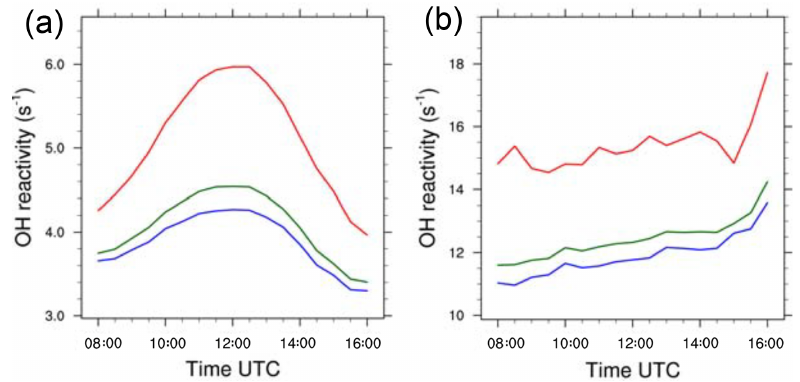
Figure 9. (a) OH reactivity (s − 1 ) in thermals (red), domain averaged (green) and in a nonthermal region (blue) averaged at z = 20m for the biogenic and (b) the anthropogenic case.